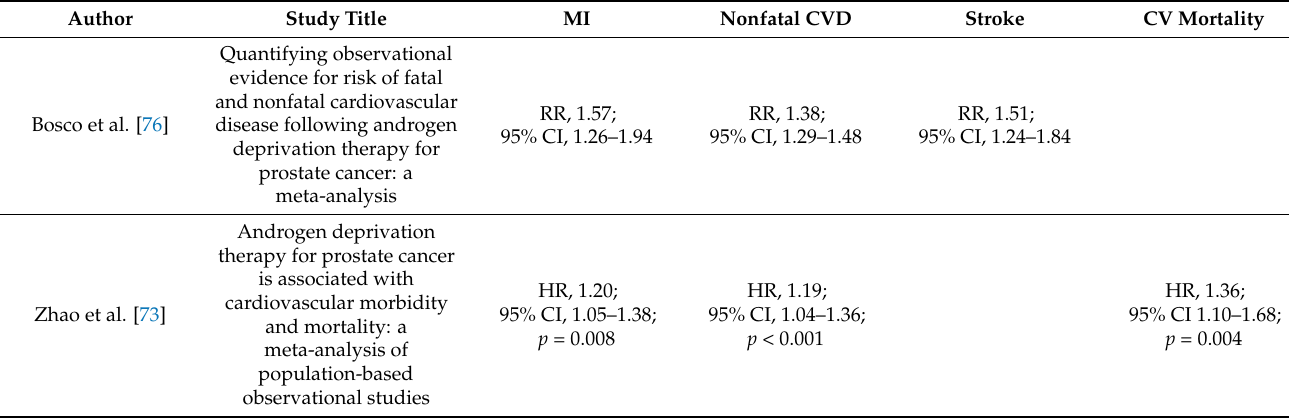
Table A2. CV Adverse Effects in Patients Receiving GnRH Agonists vs. No